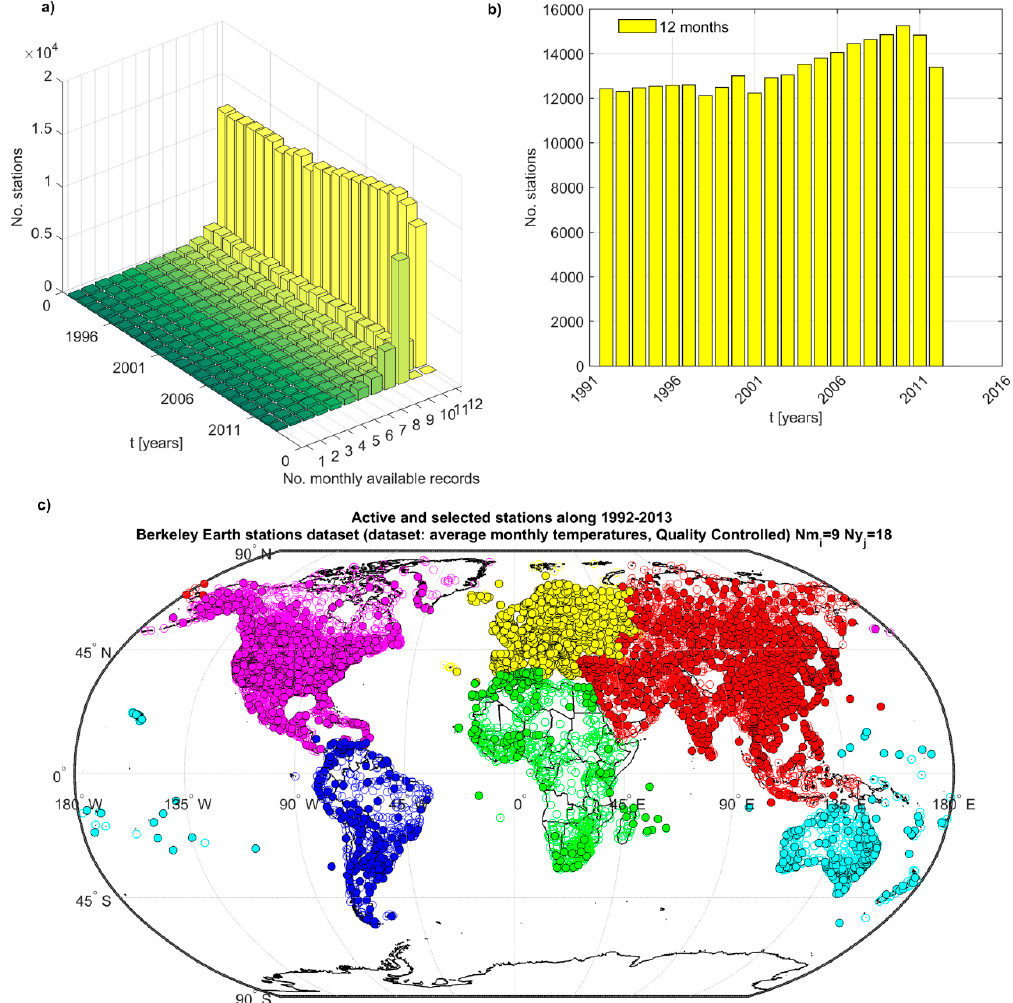
Figure 3. Geo-localization of air temperature stations from the Berkeley Earth dataset and gap-filling procedure for temperature records (dataset: average monthly temperature, Quality Controlled). ( a ) Consistency analysis of monthly and yearly availability of air temperature stations in the period from 1992 to 2013. The figure shows the number of times when it is possible to derive the temperature T using the available data records i.e., how many stations have the entire data series and, if they are incomplete, how many months per year are available per each station. ( b ) Yearly availability of air temperature stations with 12 months of records per year. ( c ) Locations of active (i.e., having at least one year of data, empty dots) and selected (i.e., meeting geo-localization and gap-filling requirements) between 1992 and 2013 (filled dots). Stations are color-coded based on the six considered regions: Africa in green, Asia in red, Europe in yellow, North America in purple, South America in blue, and Oceania in light blue.